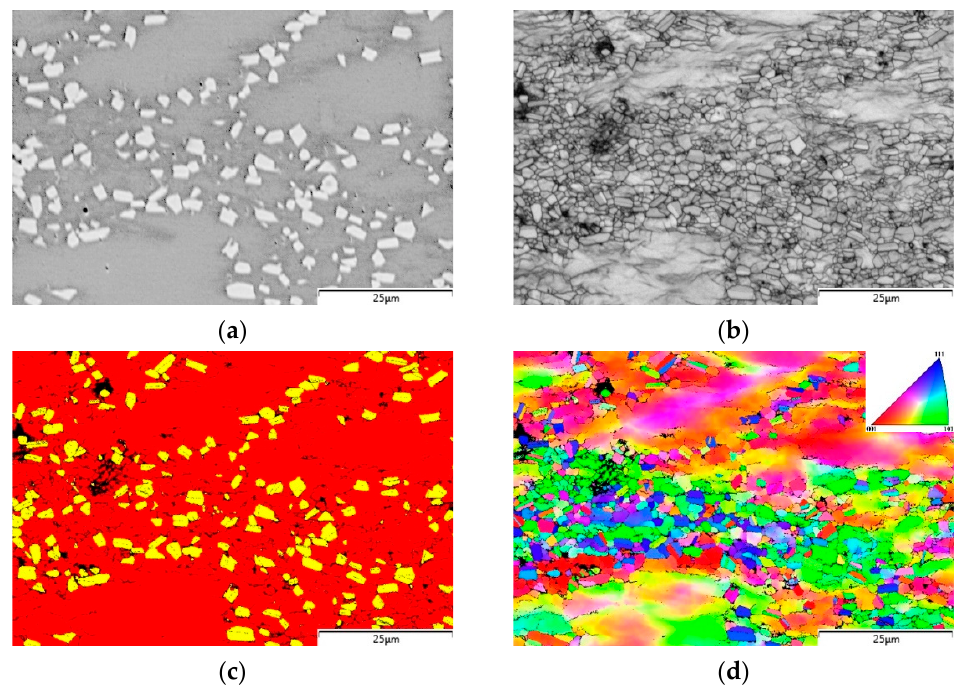
Figure 9. Re 0.3 NbTiZr after compression deformation at 1000 °C with 0.69 true strain. ( a ) Secondary electron image and ( b – d ) EBSD maps of ( b ) band contrast, ( c ) BCC (red) and FCC (yellow) phases, and ( d ) combined inverse pole figure (IPF) orientation map in the compression direction of BCC grains and FCC particles. An IPF color-coding map is shown as an insert in ( d ). The compression direction is vertical.